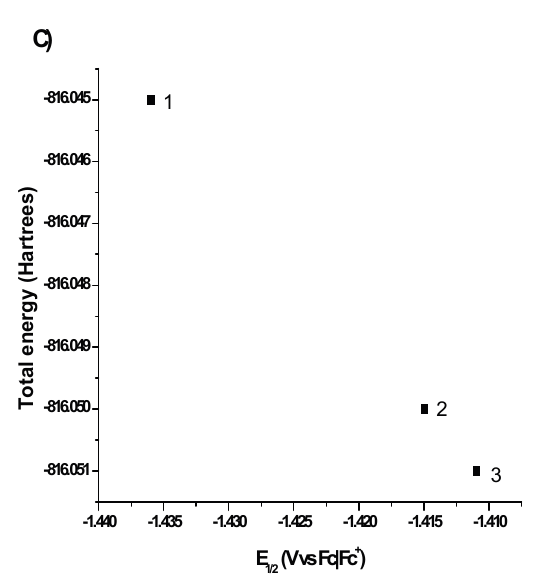
Figure 4. ( A ) Relationship found between the chemical shift of azomethine hydrogen (proton e) and the energy of the LUMO orbital; ( B ) Description of the redox potential value for the process R-NO 2 + 1e → R-NO 2• − with Δ E HOMO-LUMO values; ( C ) Change in